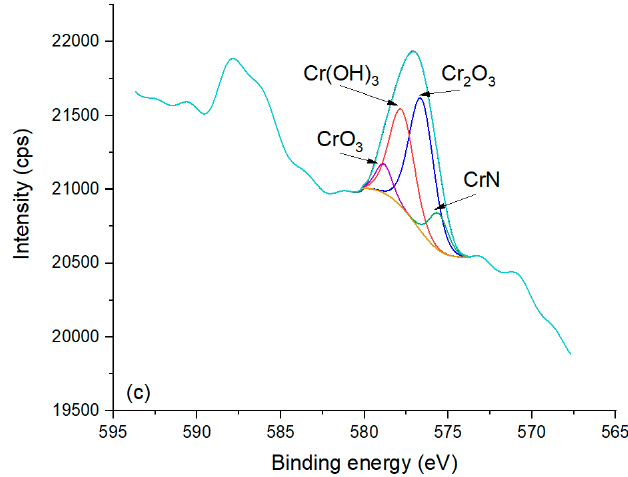
Figure 5. Cr2p3/2 XPS spectra (and its deconvolution) of the oxy-nitrided AISI 304 SS samples using: ( a ) 20 wt% urea, ( b ) 30 wt% urea and ( c ) 40 wt% urea.